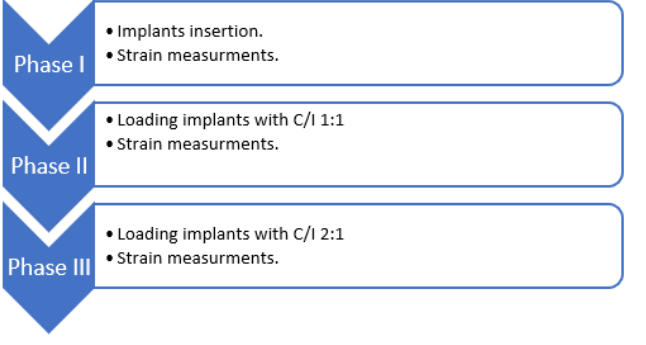
Figure 2. A diagram of the experiment design.